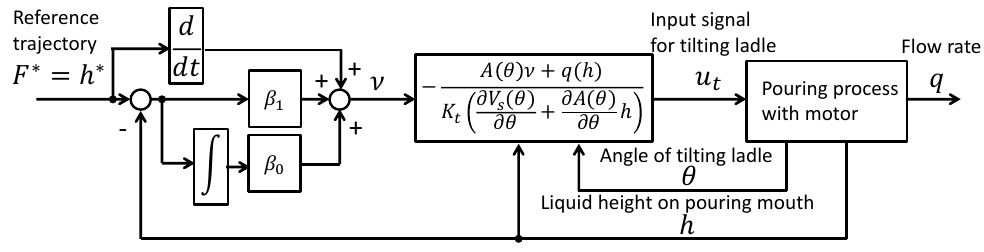
Figure 5. Signal diagram of flow rate control based on differential